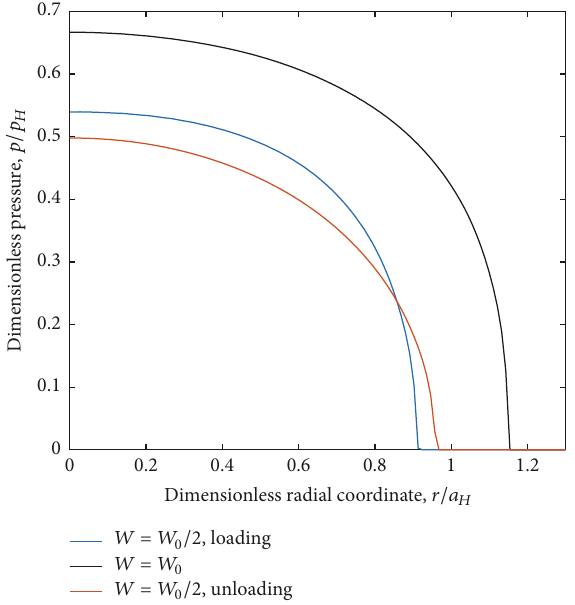
Figure 11: Pressure profiles corresponding to the same loading level, 𝑓 = 0.6 Hz ⋅ s. proven by the pressure profiles depicted in Figure 11. The gap is more apparent at smaller loading frequencies.